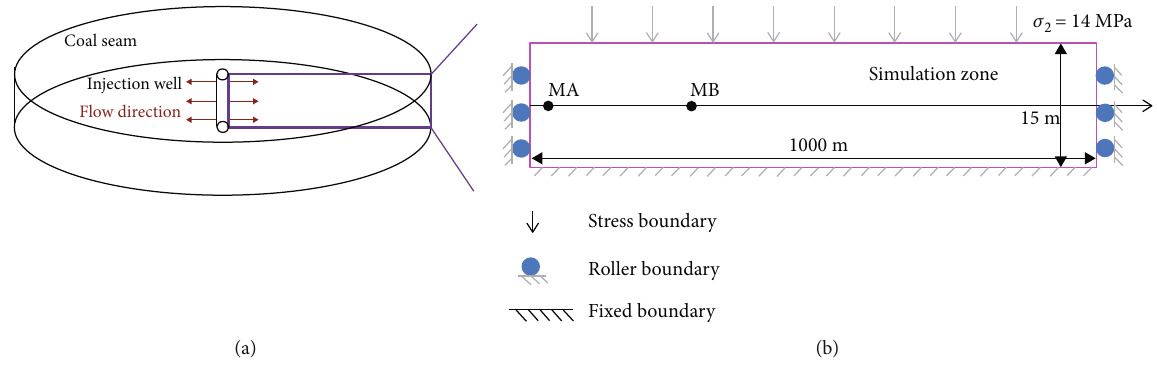
Figure 8: Schematic of the simulation model for long-term CO